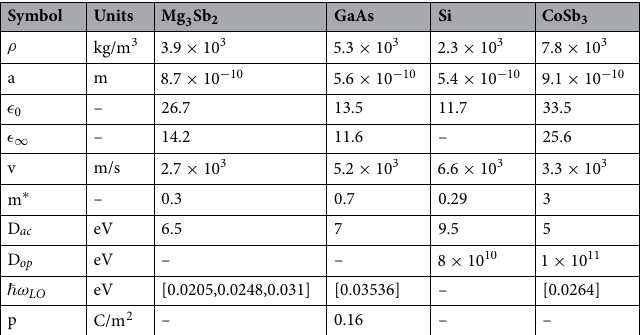
Table 2. Symbols and units of the parameters to be input in calculation of scattering models. The values for Si and GaAs are obtained from Ref. 18 , for Mg 3 Sb 2 from Ref. 20 and for CoSb 3 from Refs. 30,31 .